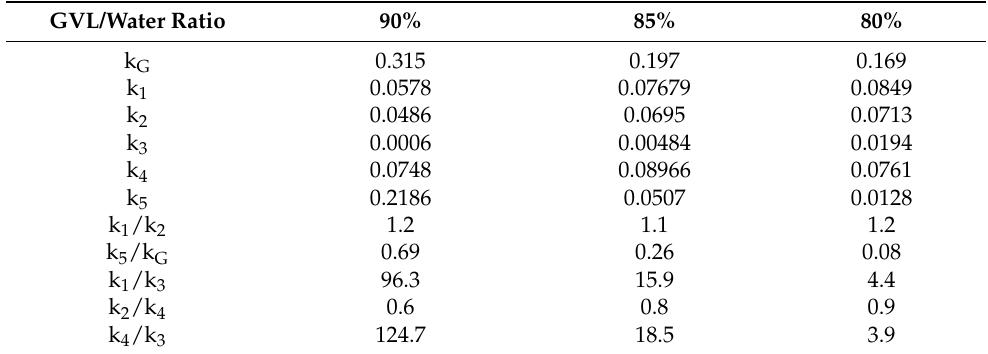
Table 4. Kinetic parameters for the conversion of glucose to furfural at a different GVL content levels. GVL/Water Ratio 90% 85% 80% k G